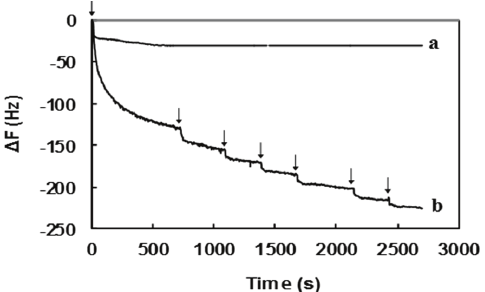
Figure 2. QCM profiles for spontaneous chemisorption of ( a ) TSC-free GlcNAc6 and ( b ) GlcNAc6-TSCs on a gold surface. Arrows indicate sample injection. Table 1. Sugar density of GlcNAc6-TSC molecules immobilized on gold surfaces.